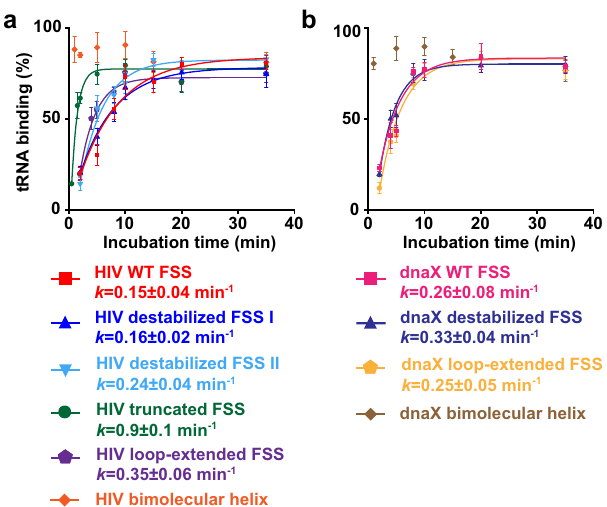
Fig. 3 The stem length and the presence of the loop are more important for the FSS-induced inhibition of tRNA binding than FSS local and overall thermodynamic stabilities. Kinetics of EF-Tu-catalyzed [ 3 H]Tyr-tRNA Tyr binding to the A site of the 70S ribosome. The ribosomes contained N -Ac- Phe-tRNA Phe in the P site and were programmed with HIV ( a ) or dnaX ( b ) mRNAs, which contained an FSS variant (Fig. 1) 11 nucleotides downstream of the P-site codon as indicated. The binding of radio-labeled [ 3 H]Tyr- tRNA Tyr to ribosomes programmed with FSS-containing mRNA is shown relative to that observed in ribosomes programmed with corresponding Δ FSS mRNA. Apparent pseudo- fi rst-order tRNA binding rates were deduced from single-exponential fi tting as shown by the line graphs. Data are presented as mean values ± standard deviations of three independent measurements. Source data are provided as a Source Data fi